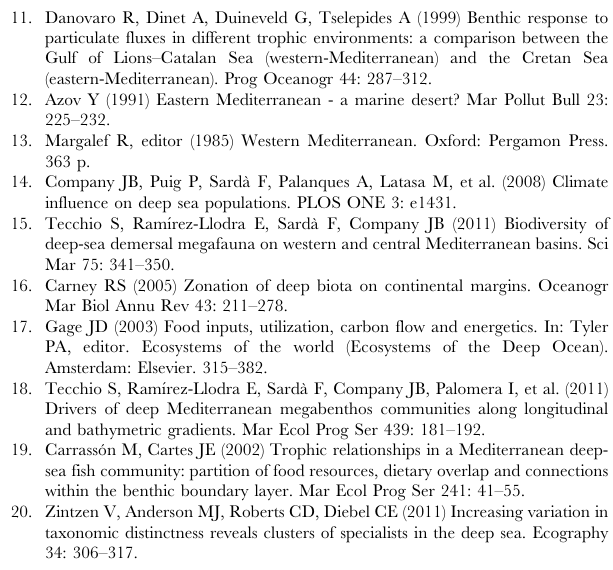
Figure S1 Benthic community niche widths in the deep Mediterranean Sea. Area of Bayesian isotopic ellipses for demersal fishes (A) and crustaceans (B) in the 3 basins of the Mediterranean Sea (WM, CM, EM) at 3 different depths (1200, 2000, and 3000 m). Black dots represent the simulated median. Boxes represent the 50%, 75% and 95% confidence intervals (dark grey to light grey, respectively). Table S1 Carbon and nitrogen isotope ratios of benthic megafauna. Values of d 13 C and d 15 N for all sampled benthic megafauna in the deep Mediterranean Sea (Mean 6 S.D.), along with the measured carbon/nitrogen ratio (C:N) and the number of analysed